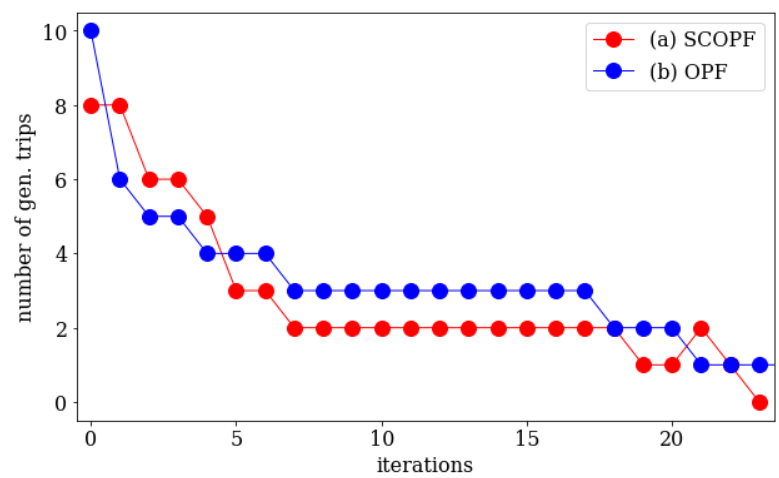
Figure 7. The total number of all generator trips in each iteration obtained in the risk optimization process for SC OPF (red) and OPF (blue)